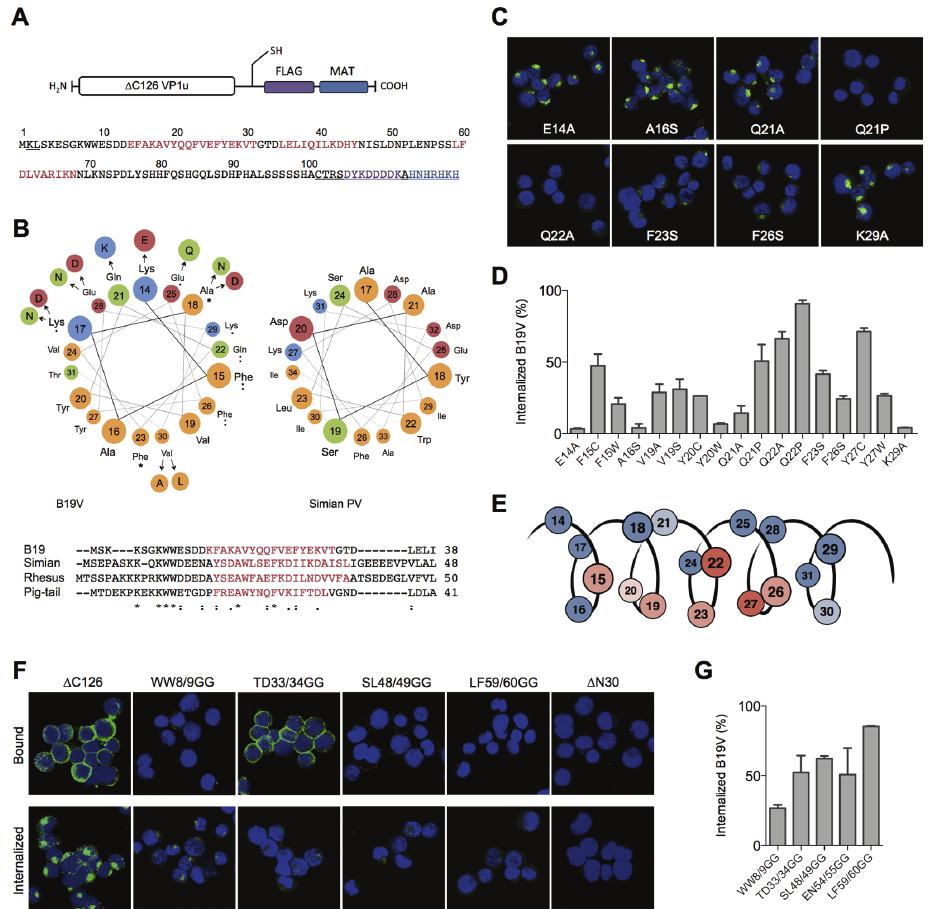
Figure 2. Structural and functional motifs within the RBD. ( A ) Schematic depiction of the recombinant ∆ C126 VP1u and its amino acid sequence (AA 1–101 of the VP1u). The sequence of the ∆ C126 harbors three predicted helices (red): AA 14–31 (helix 1), 35–45 (helix 2), and 59–68 (helix 3). Sequences of the expression vector (underlined) include the unique cysteine, the FLAG tag (violet), and the metal affinity tag (blue); ( B ) Modeled helical wheel of the conserved helix 1 and the alignment of the erythroparvovirus N-termini. The helical wheel of B19V shows the circular distribution of the AA 14–31 within helix 1 and displays the spatially related clusters of erythroparvovirus-conserved amino acids. Amino acid variations found in B19V isolates are arranged in a wider radius. The amino acids are colored according to their chemical classification: hydrophobic = yellow; polar = green; basic = blue; acid = red. The helical wheel of the simian parvovirus helix 1 is shown on the right side. The erythroparvovirus sequences from B19V, simian, rhesus macaque, and pig-tailed macaque parvovirus were aligned with ClustalW2. The secondary structure prediction with JPred shows the conservation of helix 1 (red) in all four erythroparvovirus members; ( C ) Representative immunofluorescence images of internalized recombinant VP1u mutants (green) into UT7/Epo cells; ( D ) Cellular uptake of B19V in the presence of recombinant VP1u mutants and quantification of internalized B19 virions by qPCR; ( E ) Schematic summary of the obtained data (B–D). The color of amino acids within helix 1 shows their relevance for the VP1u internalization function: red (important) to blue (not relevant); ( F ) Binding and internalization of double-glycine mutants and controls ( ∆ C126, ∆ N30); ( G ) B19V internalization in presence of the different GG-mutants. For all qPCR results n ≥ 2.